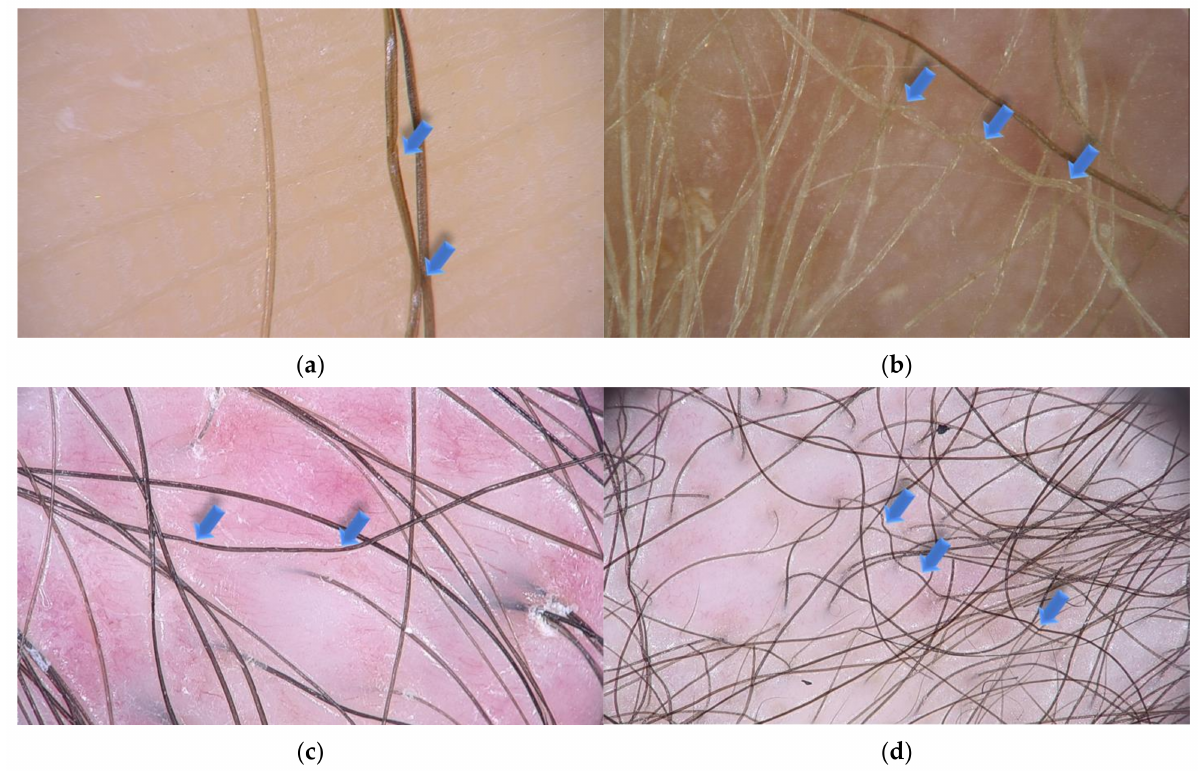
Figure 2. Trichoscopy shows pili torti (blue arrows) in various local and systemic conditions. ( a ) Pili torti in patient with late onset (Beare) type with single twists of hair ( × 70); ( b ) pili torti in patient with ectodermal dysplasia with the presence of multiple twist of hair ( × 50); ( c ) pili torti in patient with lichen planopilaris. Perifollicular scaling and milky-red areas are also presented ( × 20); ( d ) numerous pili tori in patient with mycosis fungoides ( ×